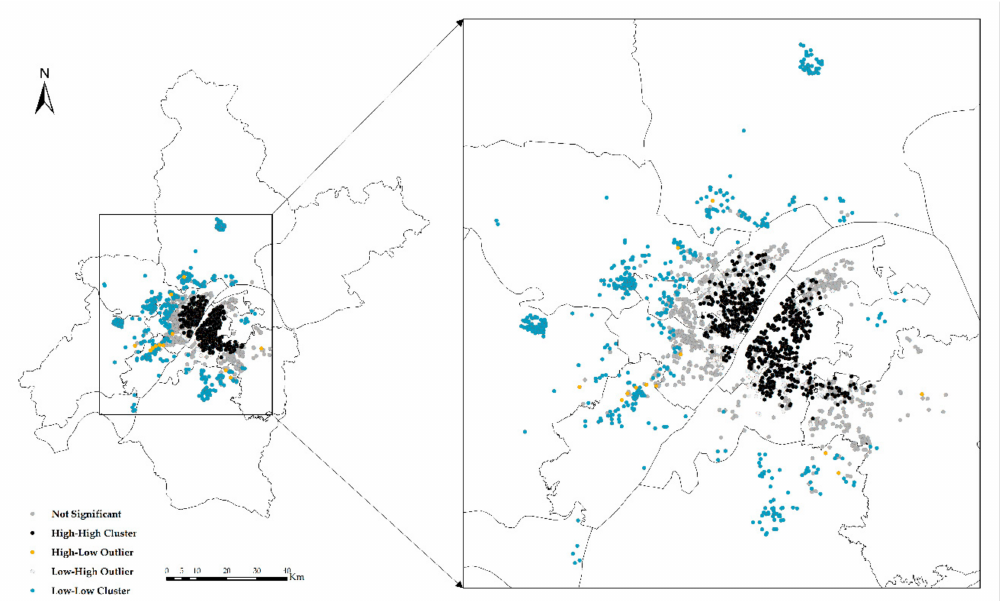
Figure 6. Clustering and outlier analysis of the community housing price (CHP).